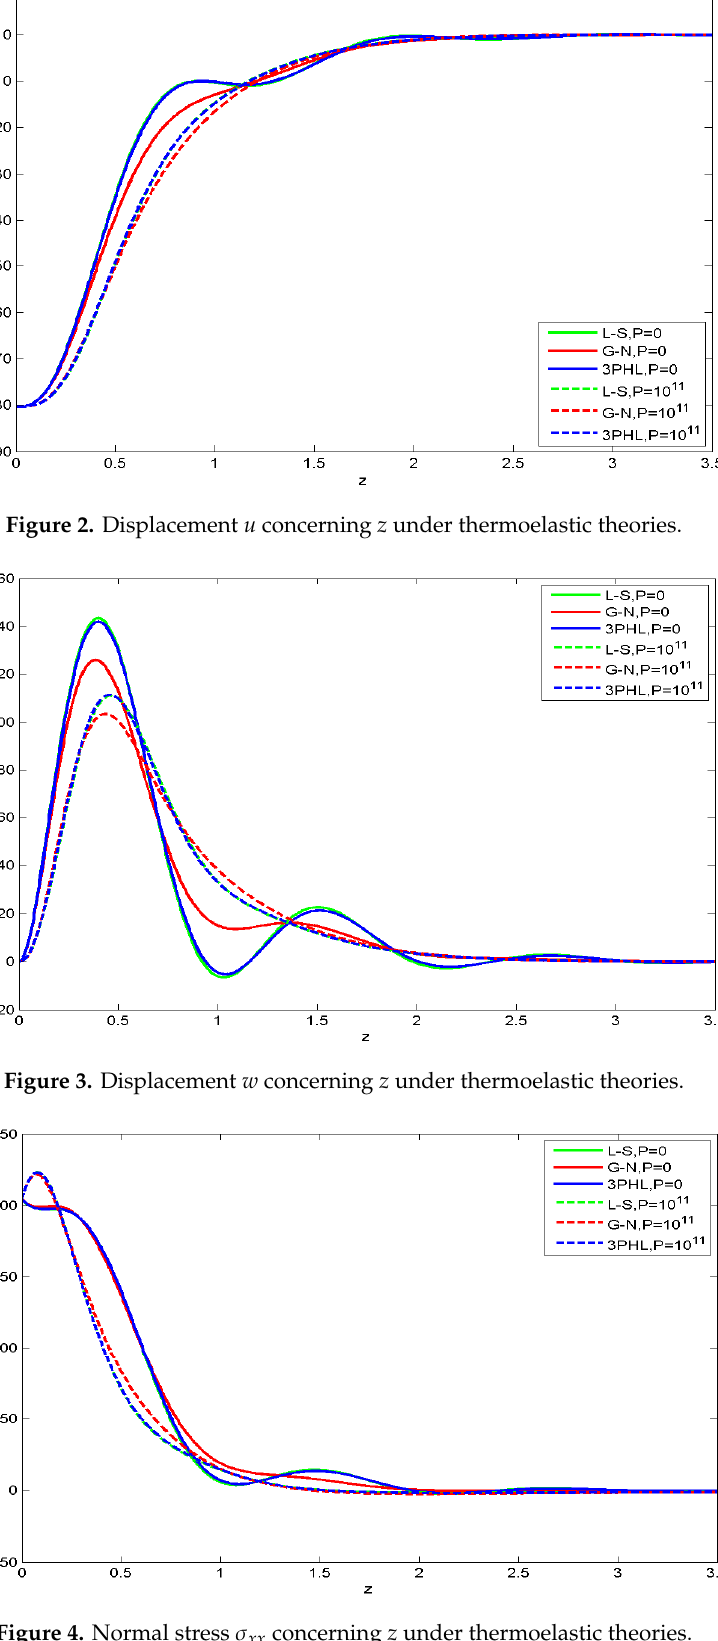
Figure 4. Normal σ concerning z under thermoelastic theories. Figure 4. Normal stress xx